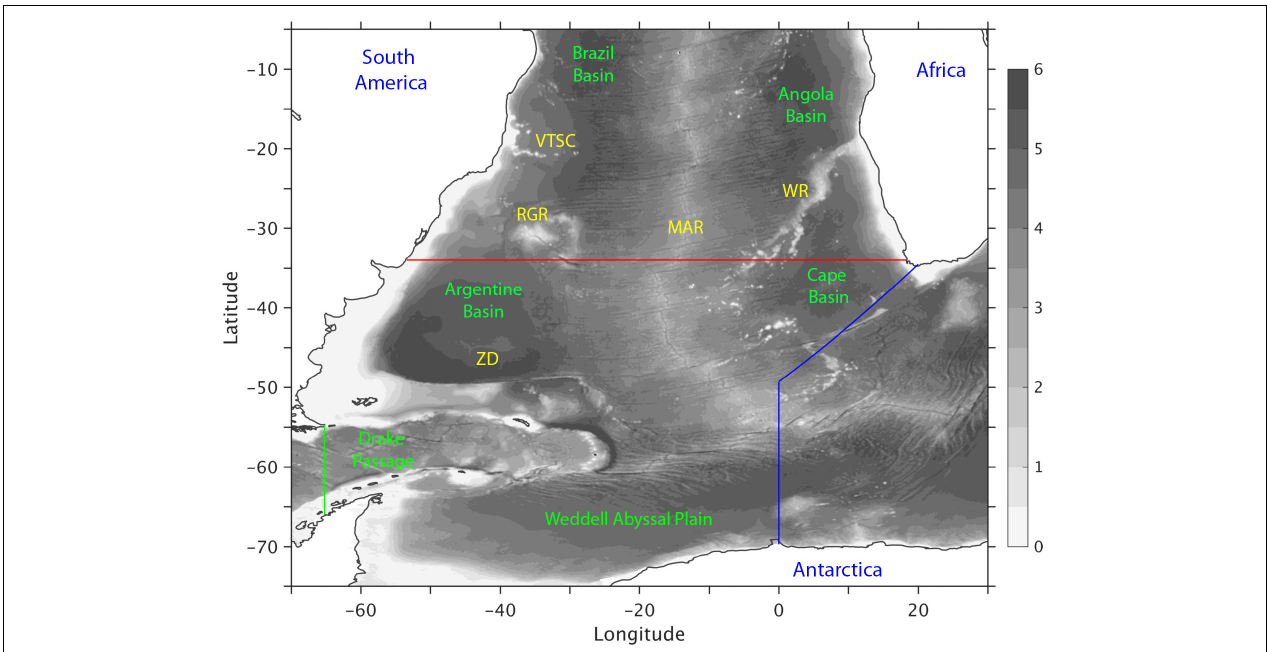
FIGURE 1 | Model bathymetry (in km) along with key topographic features in the South Atlantic Ocean: Vitoria-Trindade Seamount Chain (VTSC), Rio-Grande Rise (RGR), Mid-Atlantic Ridge (MAR), Walvis Ridge (WR), Zapiola Drift (ZD). Red, green, and blue lines denote three sections where significant observations have been obtained and the observations are used to evaluate the model results: 34 ◦ S in the South Atlantic, 65 ◦ W in Drake Passage, and the Prime Meridian-Good Hope (PM-GH) transect southwest of